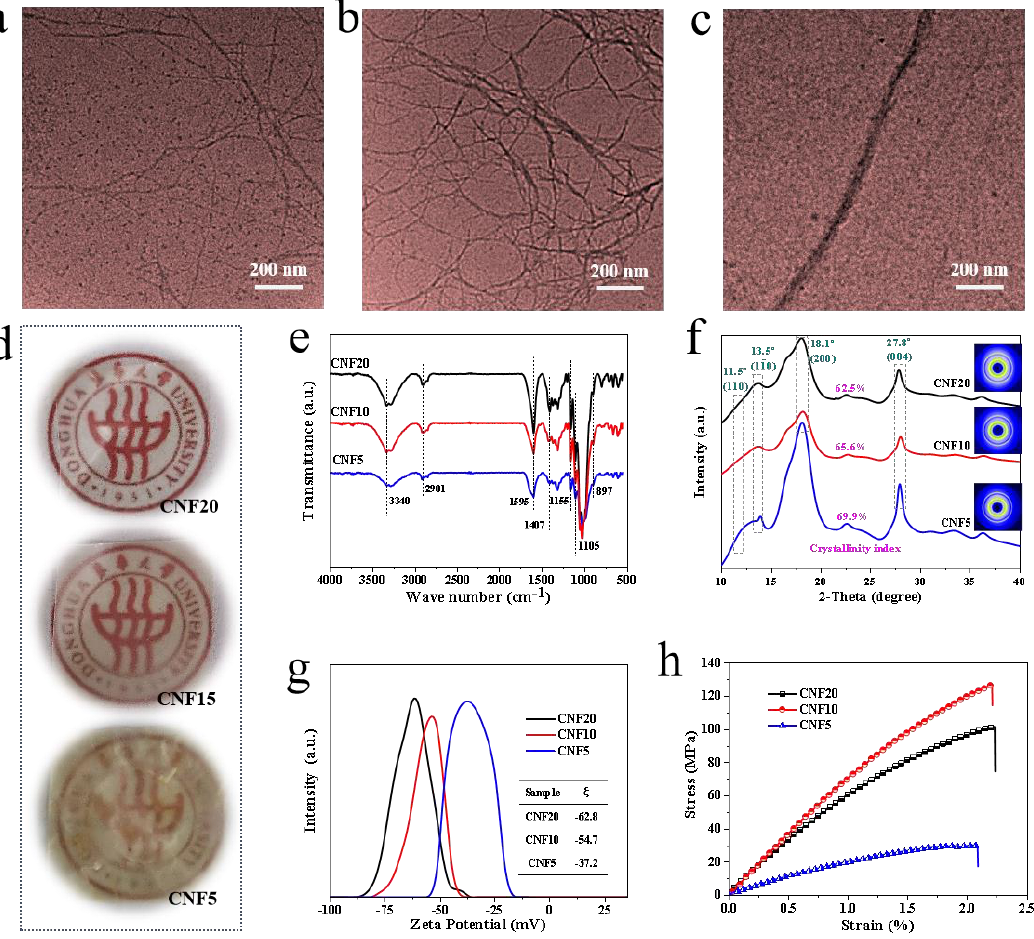
Figure 2. The TEM images: ( a ) CNF20; ( b ) CNF10; ( c ) CNF5; ( d ) Optical images of the films; ( e ) FTIR spectrum of CNF/PVA; ( f ) 1D-WAXS of CNF/PVA; ( g ) Zeta potential distribution of CNF/PVA; ( h ) Stress-strain curves of CNF/PVA.